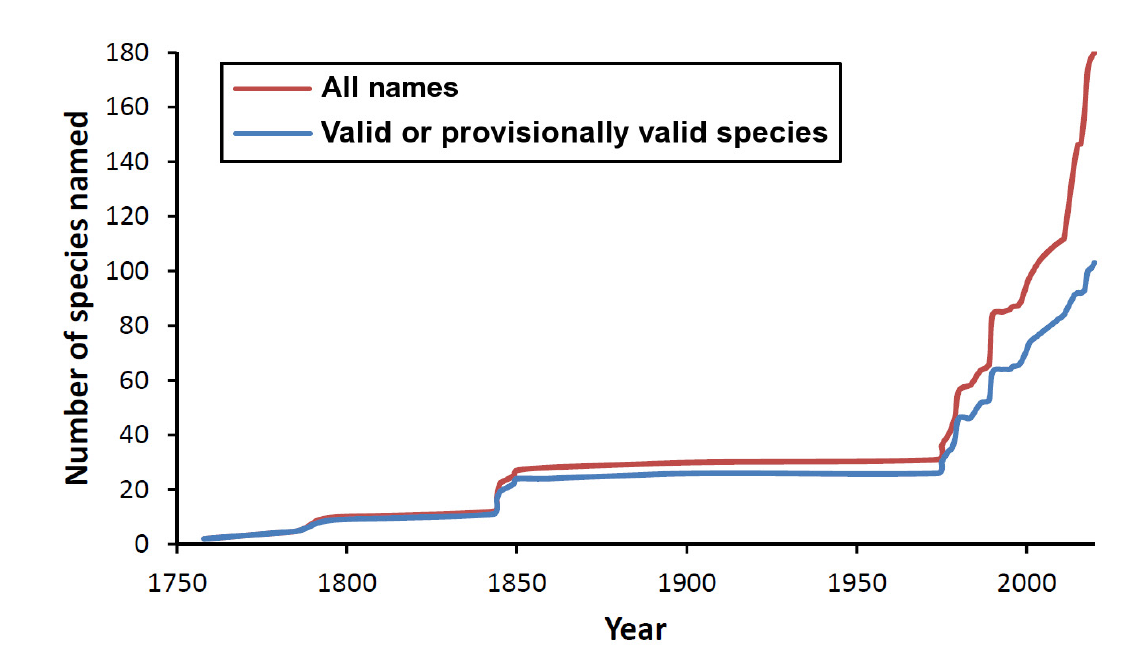
Fig. 1. Cumulative number of described (red) and valid or provisionally valid (blue) West African cone species per year after